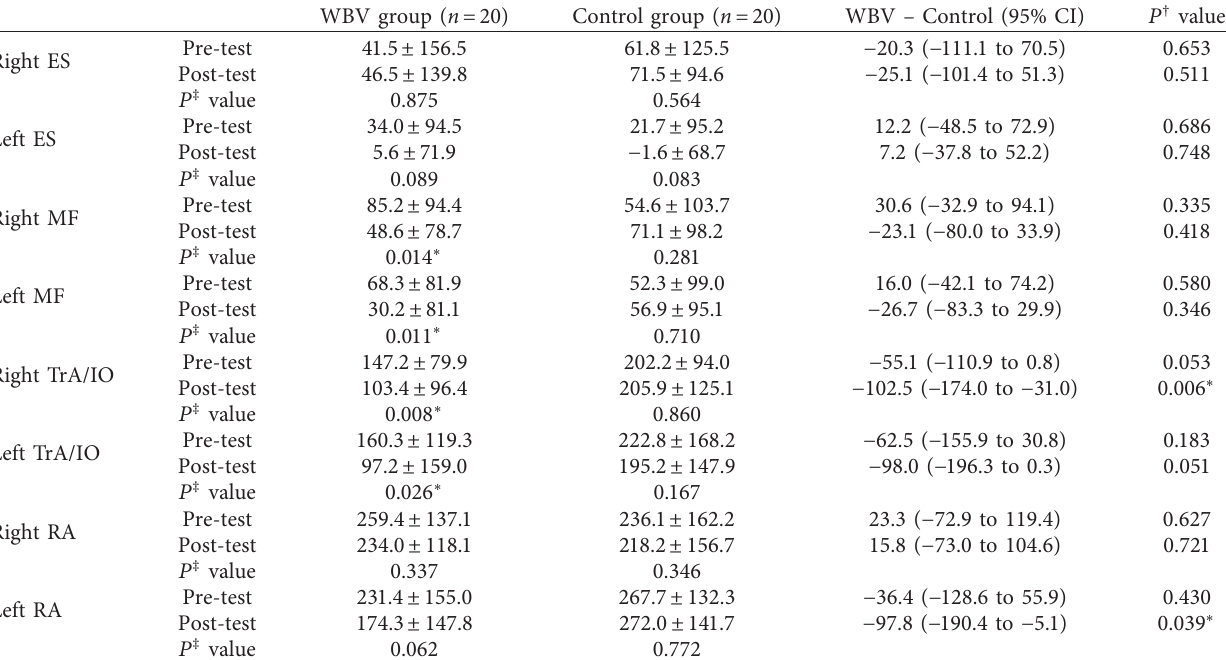
Table 3: Comparison of relative activation time between/within groups on shoulder flexion ( x ± s , unit: